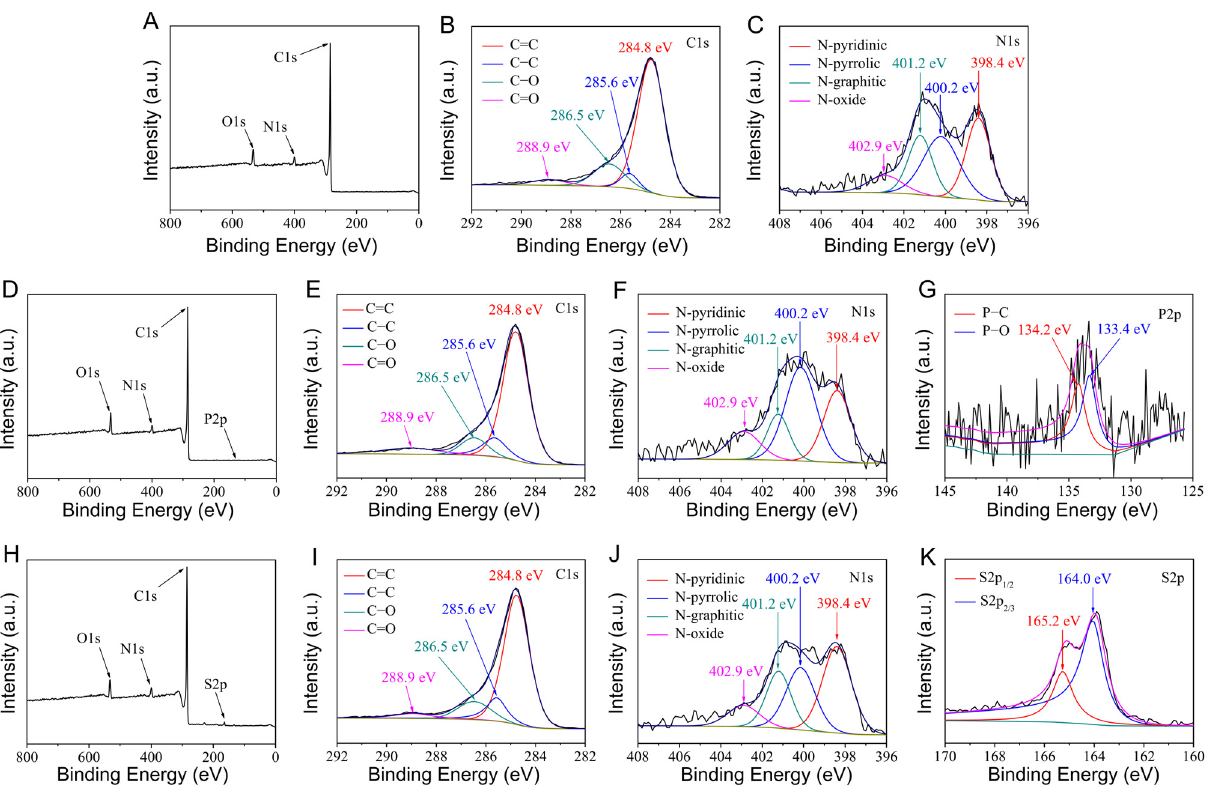
Figure 5. ( A ) the whole XPS surveys, ( B ) C1s, and ( C ) N1s spectrum of NDCX; ( D ) the whole XPS surveys, ( E ) C1s, ( F ) N1s, and ( G ) P2p spectrum of P ‐ NDCX ‐ 1.0; ( H ) the whole XPS surveys, ( I ) C1s, surveys, ( E ) C1s, ( F ) N1s, and ( G ) P2p spectrum of P-NDCX-1.0; ( H ) the whole XPS surveys, ( I ) C1s, ( J ) N1s, and ( K ) S2p spectrum of S ‐ NDCX ‐ 1.0. ( J ) N1s, and ( K ) S2p spectrum of